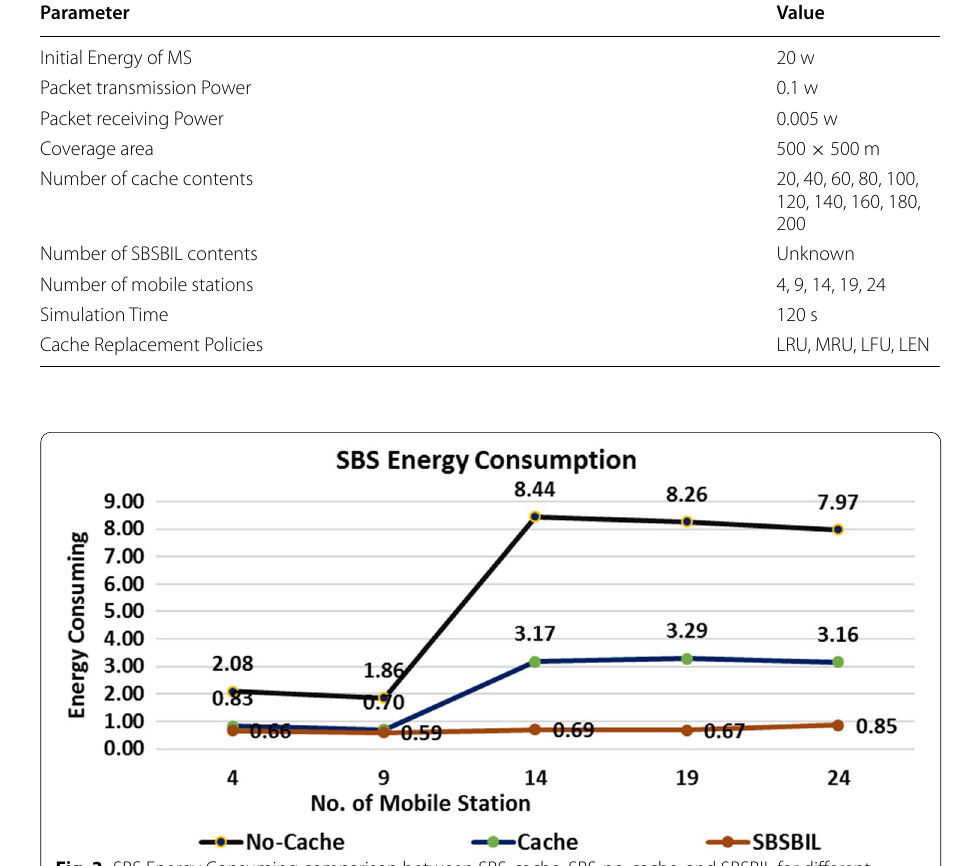
Fig. 3 SBS Energy Consuming comparison between SBS‑cache, SBS‑no‑cache, and SBSBIL for different number of